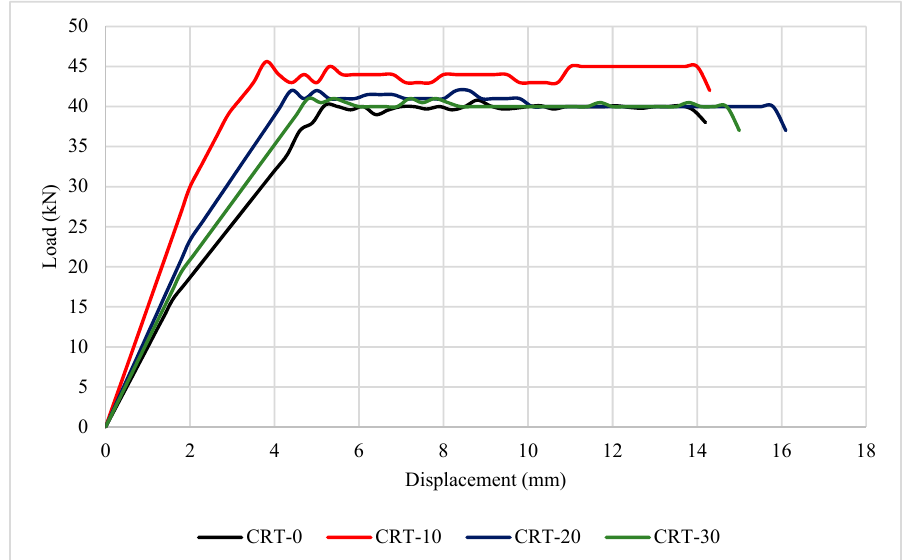
Figure 6. Load versus central deflection for beams with different CRT replacement levels.